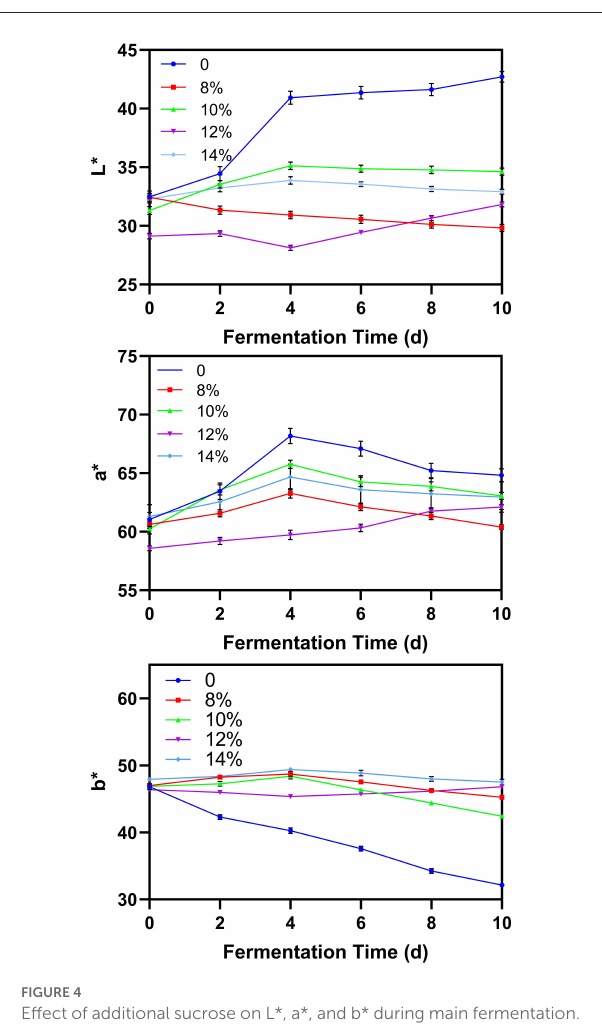
FIGURE2 Effect of additional sucrose on acid content. Different superscript letters in the graph are significantly different ( P < 0.05).